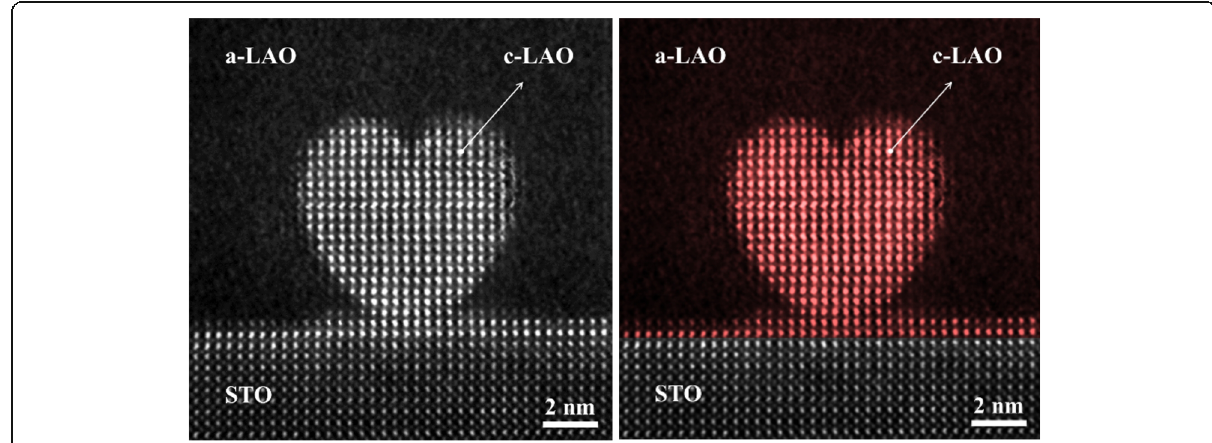
Fig. 1 A high-angle annular dark-field scanning transmission electron microscopy (HAADF STEM) (left) and colored image (right) of the sculptured heart-shaped crystallized LAO in the a-LAO region through e-beam irradiation in